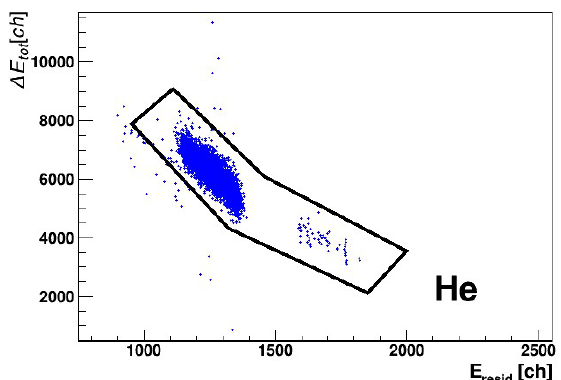
Fig. 1. A typical ΔΕ tot versus residual energy ( E resid ) spectrum for a single silicon detector of the FPD.